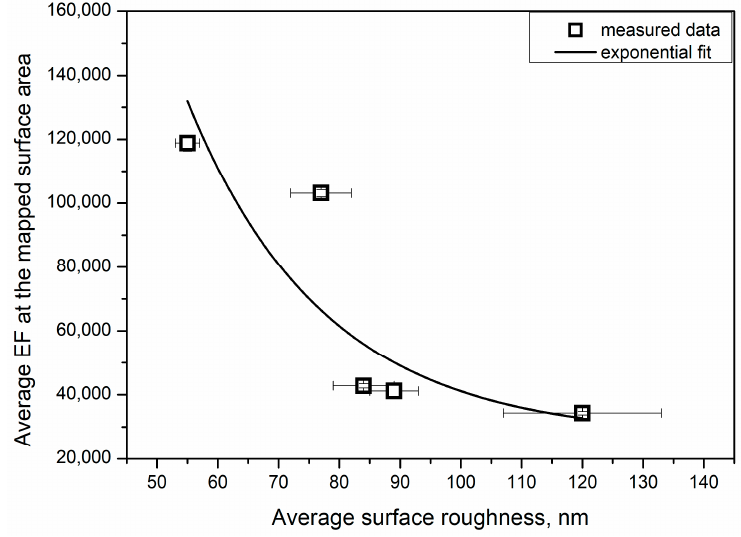
Figure 8. Average EF factor of mapped surface areas as a function of roughness.